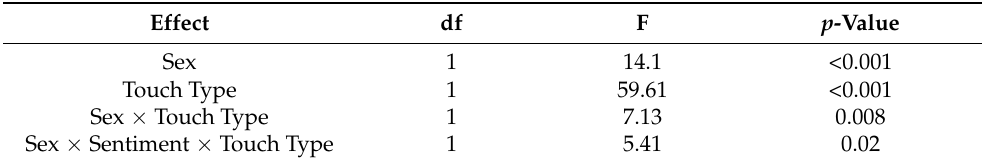
Table 7. Significant main effects on change in physiological arousal from affective or non-affective mediated